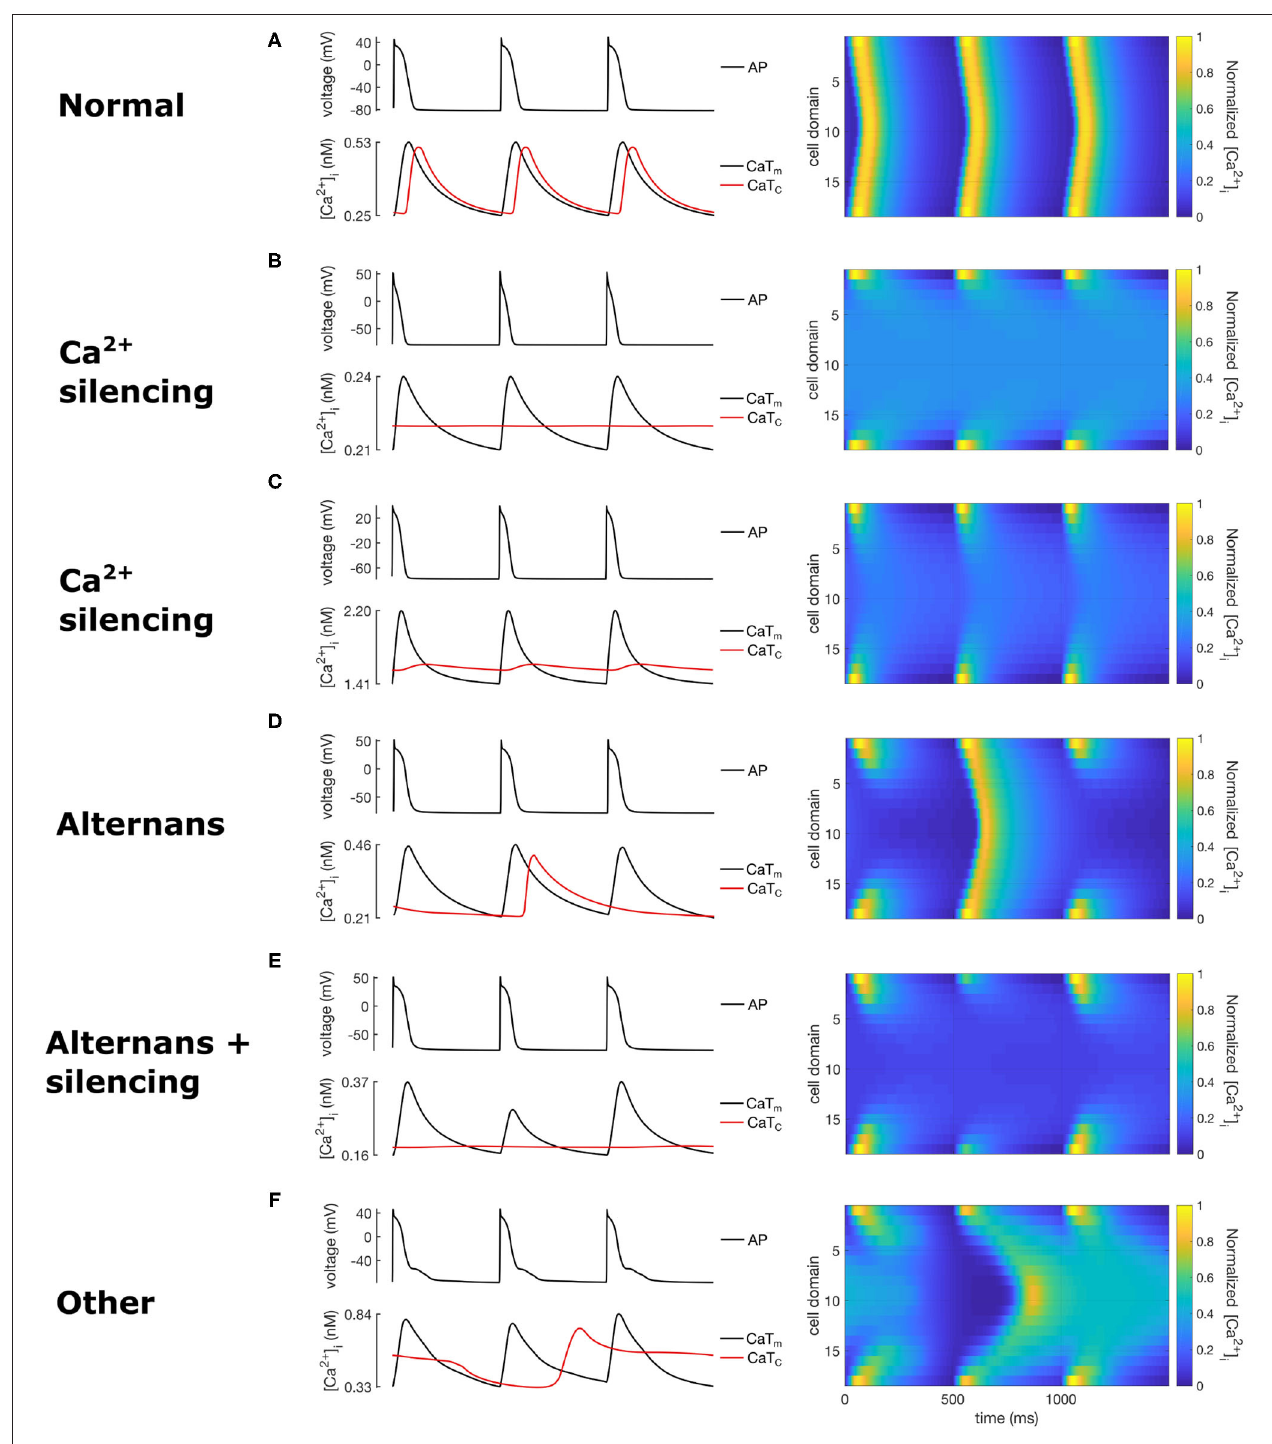
FIGURE 4 | Exemplary calcium waves from the RAP remodeled populations showing calcium propagation patterns from the 5 wave categories. The left column shows AP and calcium transients, while the right column shows the corresponding spatio-temporal calcium wave plots. (A) corresponds to category 1 (normal), (B,C) to category 3, (D) to category 2, (E) to category 4, and (F) to category 5.